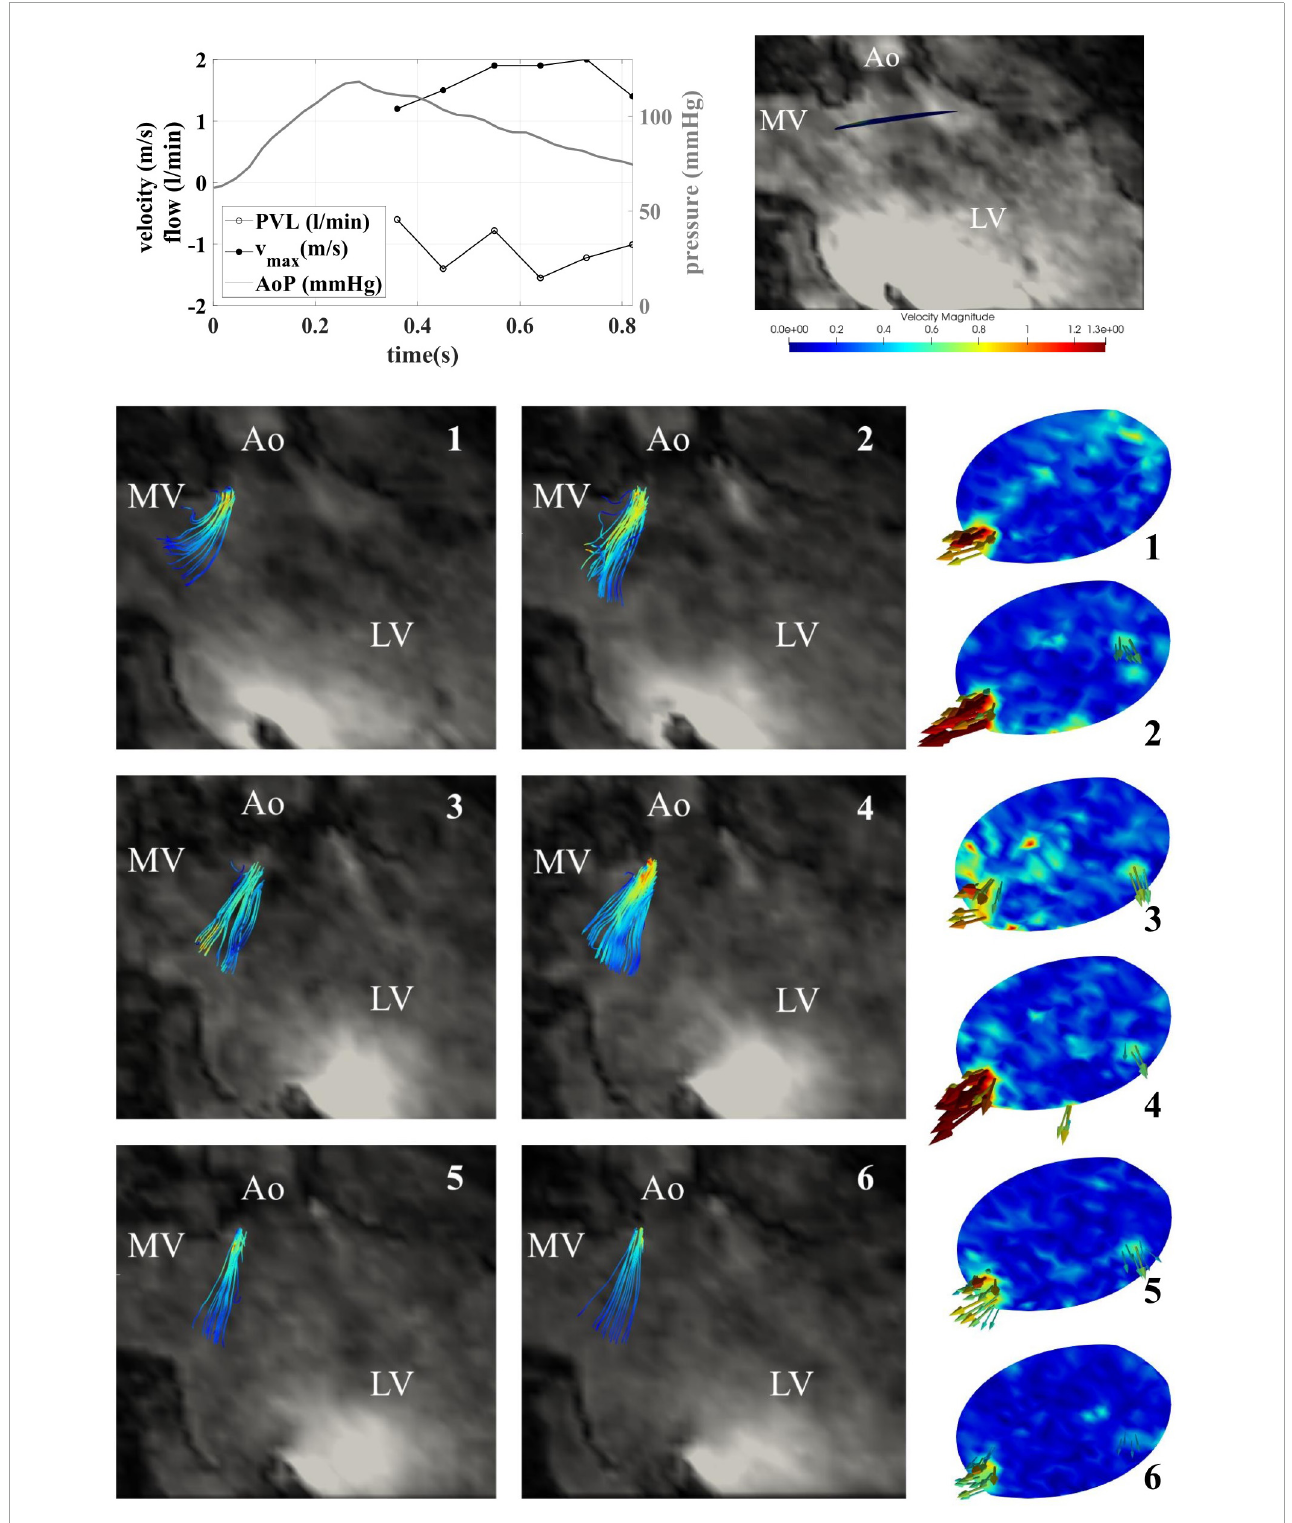
FIGURE8 Retrograde pulsatile paravalvular leaks (PVL) streamlines shown for 6 diastolic timepoints in the 3-chamber view (left) and the xz-plane (center) and paravalvular jets in the plane directly below the transcatheter aortic valve implantation (TAVI) (right)